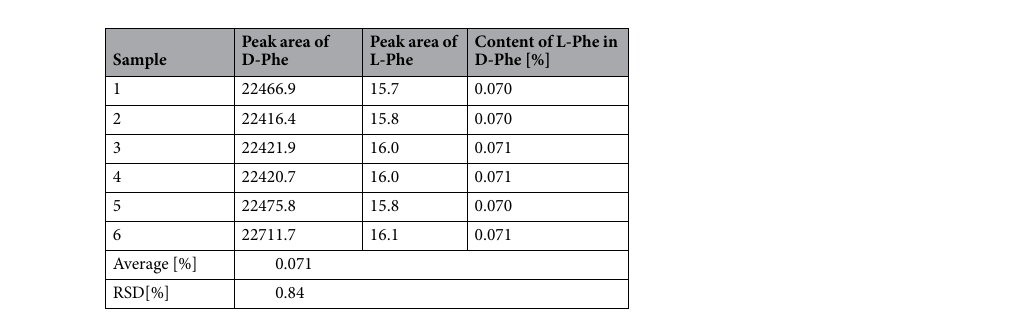
Table 1. Mass fraction of L-phenylalanine in D-phenylalanine.